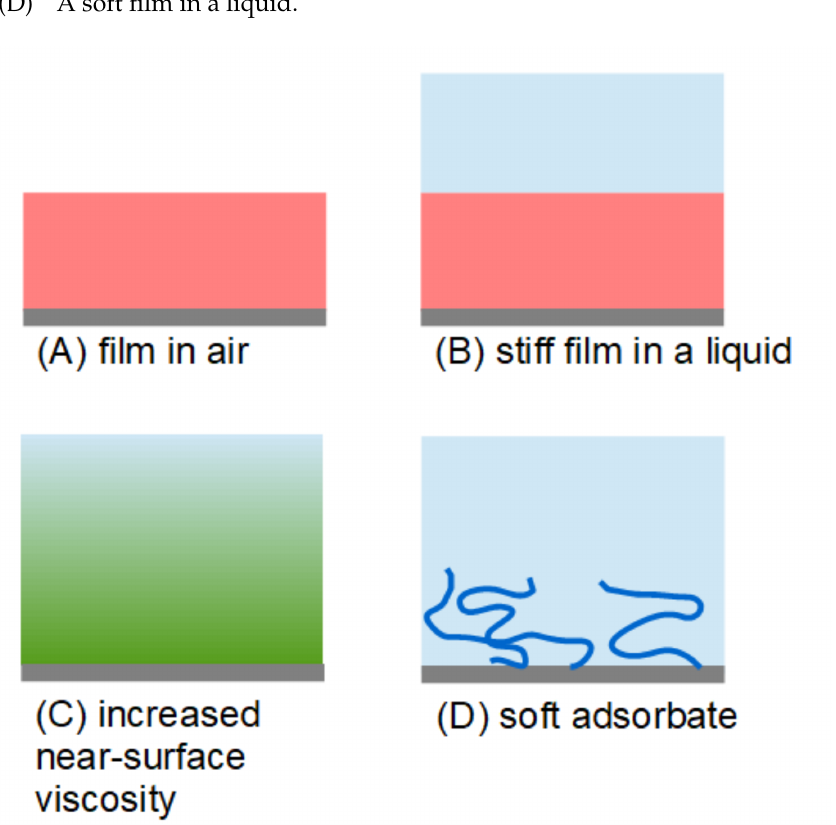
Figure 1. A set of configurations in which the interpretation proceeds in different ways. For cases ( A , B ) the values of ∆ f / n and ∆Γ / n can be interpreted, respectively, at least approximately. For systems with increased near-surface viscosity ( C ), ∆ f / n and ∆Γ / n have an interpretation, but the width of the range, inside which the viscosity is increased, is no longer accessible. Interpretation is difficult for soft adsorbates ( D